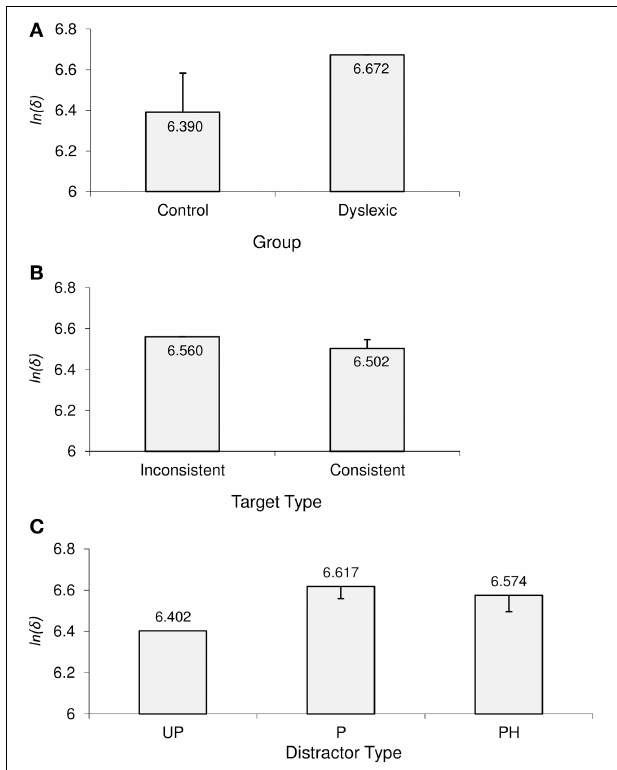
FIGURE 7 | Significant effects in home-in time [ln( γ × β /(1 + γ ))]. (A) Main effect of group; (B) main effect of target type; (C) main effect of distractor type. Error bars represent Sidak-adjusted 95% confidence half-widths for (A) the group contrast, (B) the target type contrast, and (C) contrasts with the UP distractor condition. Significant differences must exceed those half-widths. UP, unpronounceable; P, pronounceable; PH,